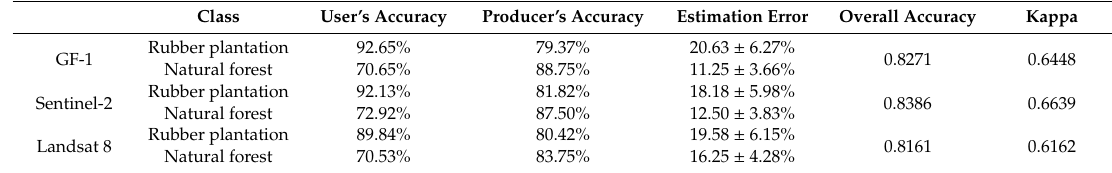
Table 4. Accuracy validation of RF classification using only spectral information.